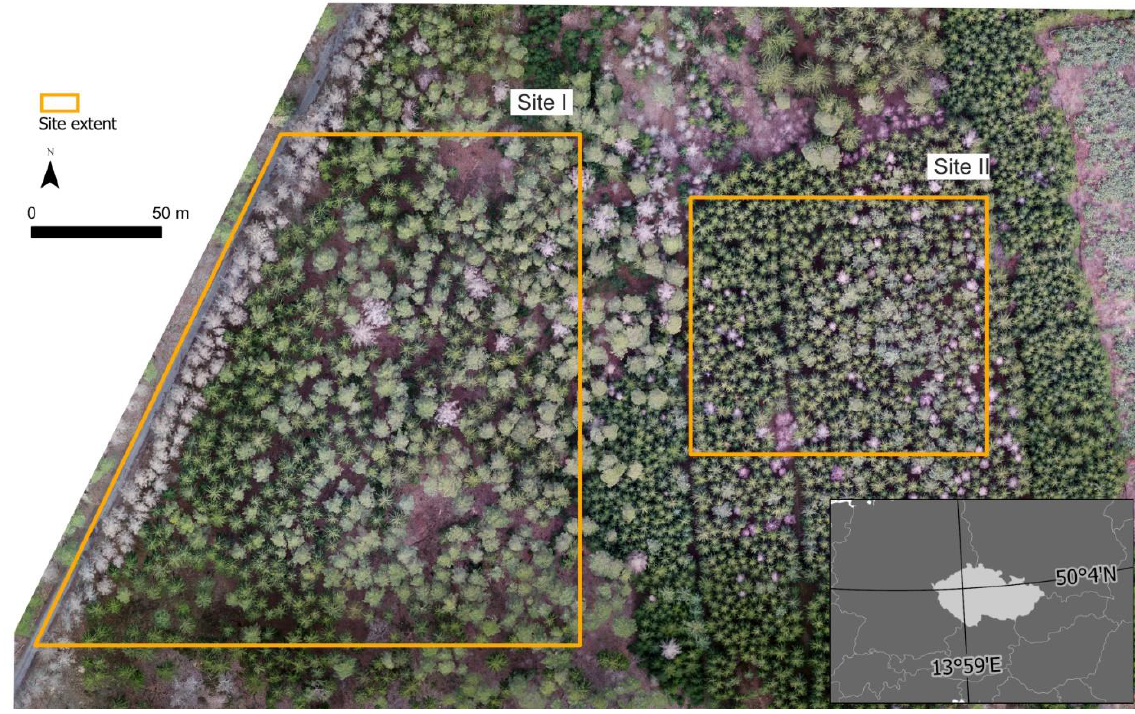
Figure 1. Study site overview — two tested sites: (Site I) full-grown 80 – 100 year-old mixed coniferous forest; (Site II) forest with the dominance of spruce, 20 – 40 years old. Basemap source: orthomosaics acquired from a Phantom 4 Pro at 200 m above ground.